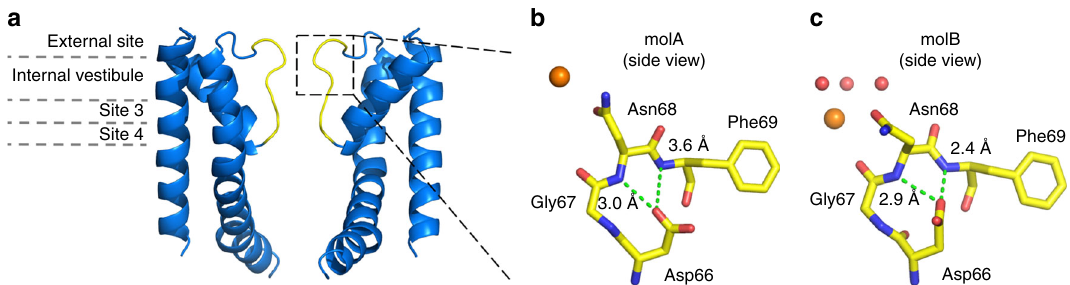
Fig. 4 Hydrogen bonding in NaK structures to stabilize Asn68. a Side view of the overall structure (blue) of NaK in a cartoon representation, while the front and back subunits are removed for clarity. b , c The external sites from molA and molB monomers are shown in stick models, respectively. The hydrogen bonds and corresponding distances are indicated in green dashed lines, and Na + ion and waters as orange and